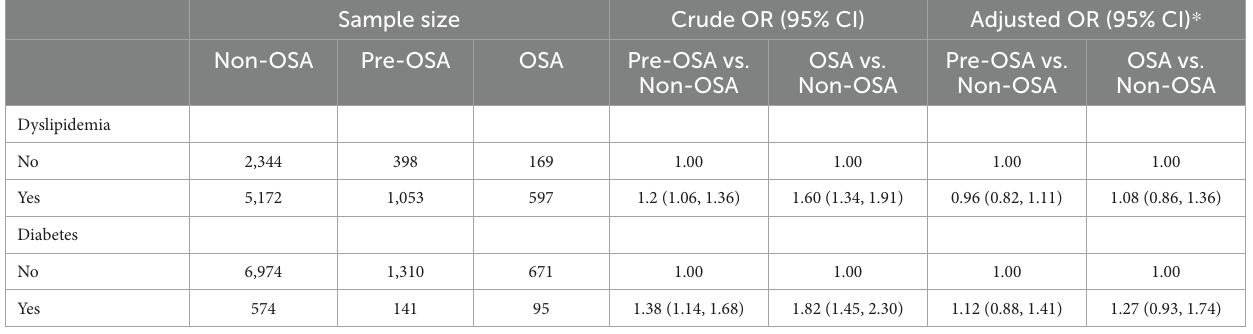
TABLE 5 Association between dyslipidemia and diabetes and risk of pre-OSA and OSA after excluding participants with COPD and CVDs. Sample